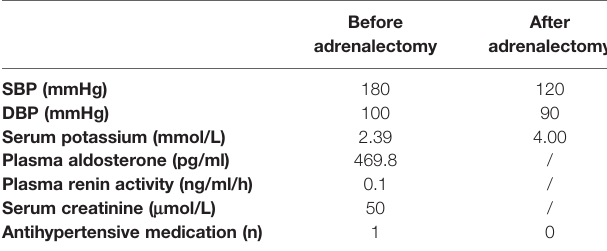
TABLE 1 | Baseline and post-left-adrenalectomy clinical characteristics in 2004.